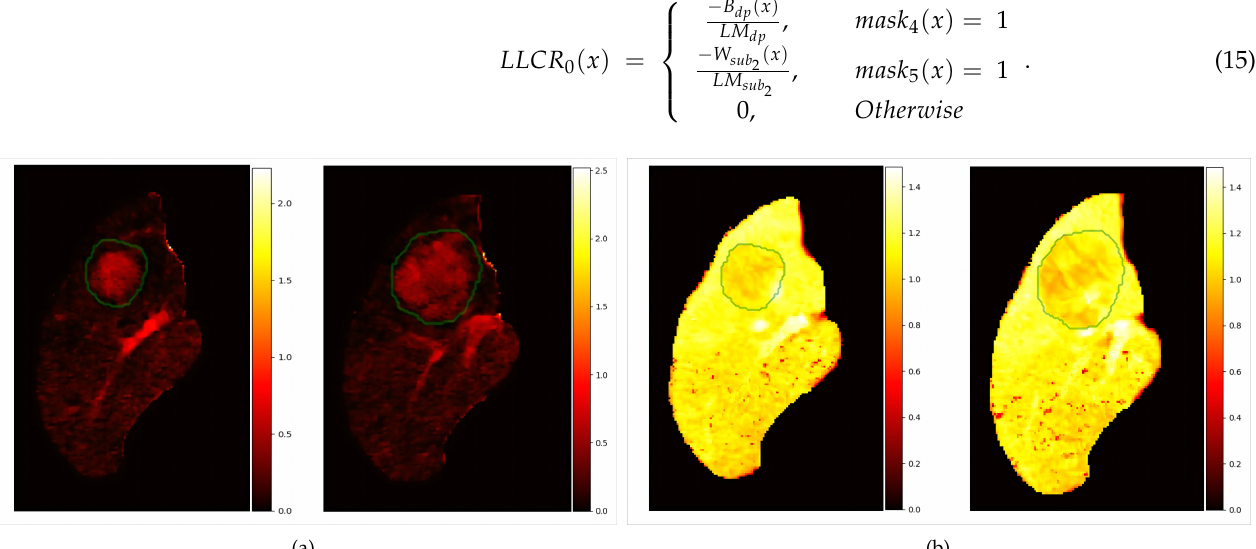
Figure 4. The parameterization results: ( a ) shows two slices of APHE results and ( b ) shows two slices of WO results. The green contour is the lesion contour in the AP